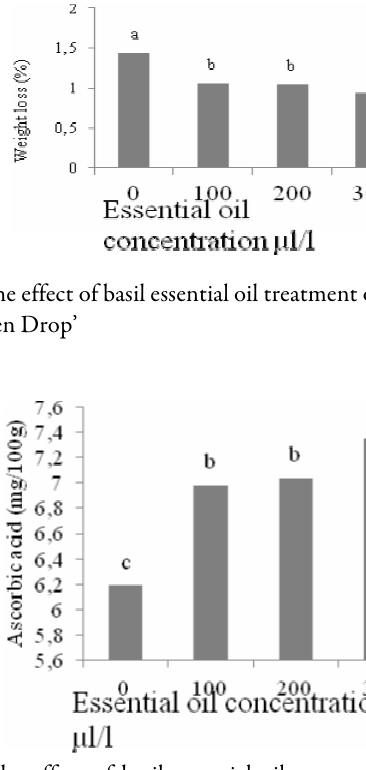
Fig. 5. The effect of basil essential oil treatment on firmness of ‘Golden Drop’ plums